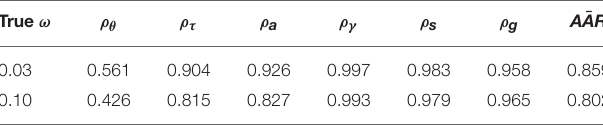
TABLE 8 | Recovery of the model parameters when the mixture in the data is ignored. True